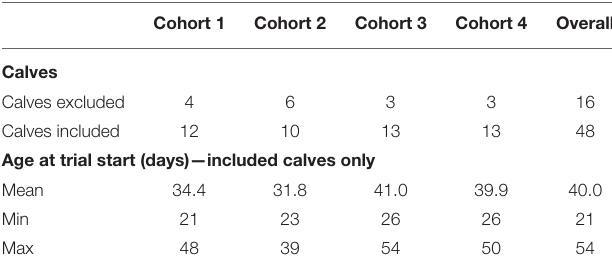
TABLE 1 | Number of calves included in analysis per cohort as per the inclusion criteria detailed in the methods and age of calves at start of data